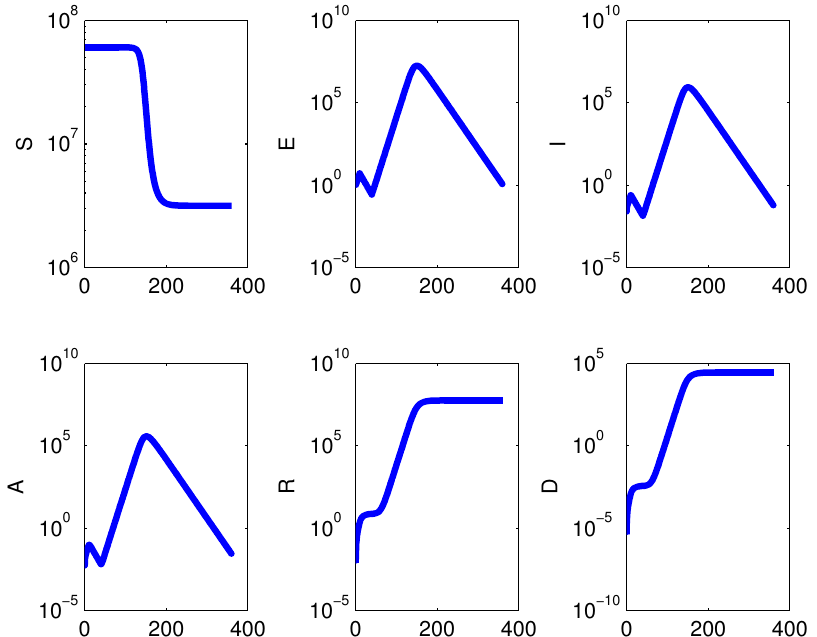
Figure 9. Using a semilogarithmic scale for the vertical axis, we show the results of starting the restrictions at time t 1 = 10, setting β I = 10 − 10 and lifting them at time t 2 = 30, returning to β I = 10 − 7 one months later, over a one year timespan for the simplified model with no demographics (1) where we take Λ = 0, d p = 0. Left to right and top to bottom, the subpopulations are: S , E , I , A , R and D , the disease-related deceased class.